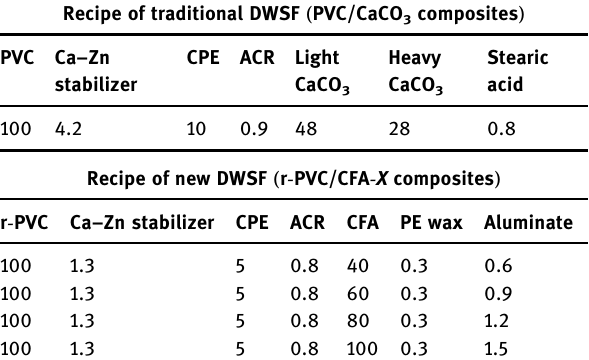
Table 2: Recipes of traditional and new DWSF composites Recipe of traditional DWSF ( PVC/CaCO 3 composites